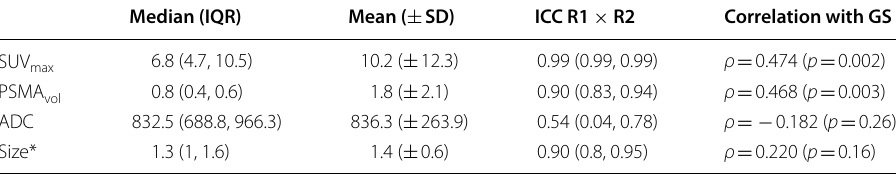
Median, mean and correlation with GS based on results from the more experienced reader GS, Gleason score; IQR, interquartile rage (Q1, Q3); ICC, intraclass correlation coefficient; R1, reader 1; R2, reader 2; SD, standard